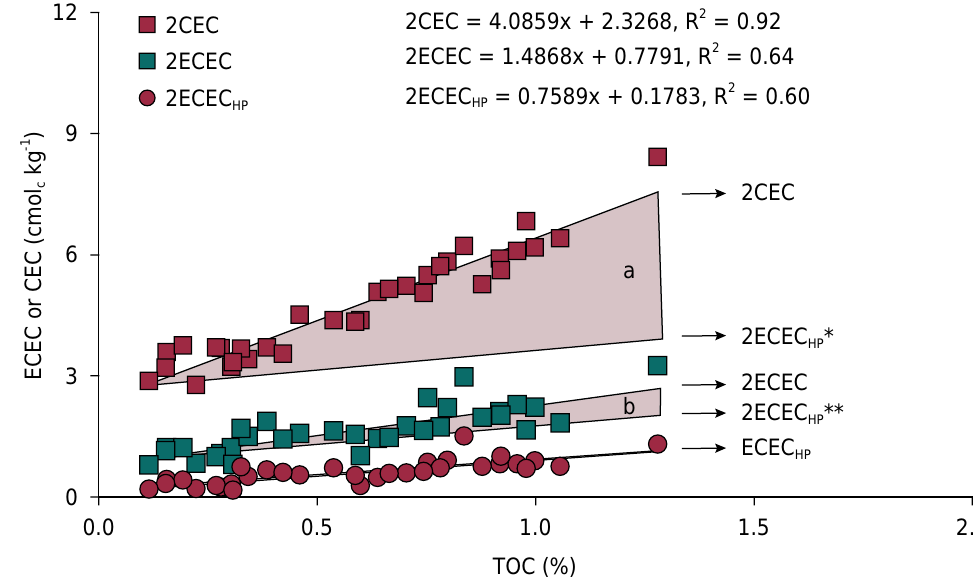
Figure 3. Cation exchange capacities (CEC and ECEC) and total organic carbon (TOC) content for the soil samples measured with the mechanical extractor before (2CEC and 2ECEC) and after SOM removal (2ECEC HP ). * and ** are lines obtained from values calculated from the equation 2ECEC HP = 0.7589 x TOC (%) + ECEC IF , considering as linear coefficients (ECEC IF ) equal to 0.78 and 2.33, respectively. Sectional areas (a) and (b) represent the negative surface proton density (σ H ) of the SOM between pH~5.6 (2ECEC HP ) and pH 7 (2CEC) and ECEC at pH~5.6, respectively, for the carbon content range of the